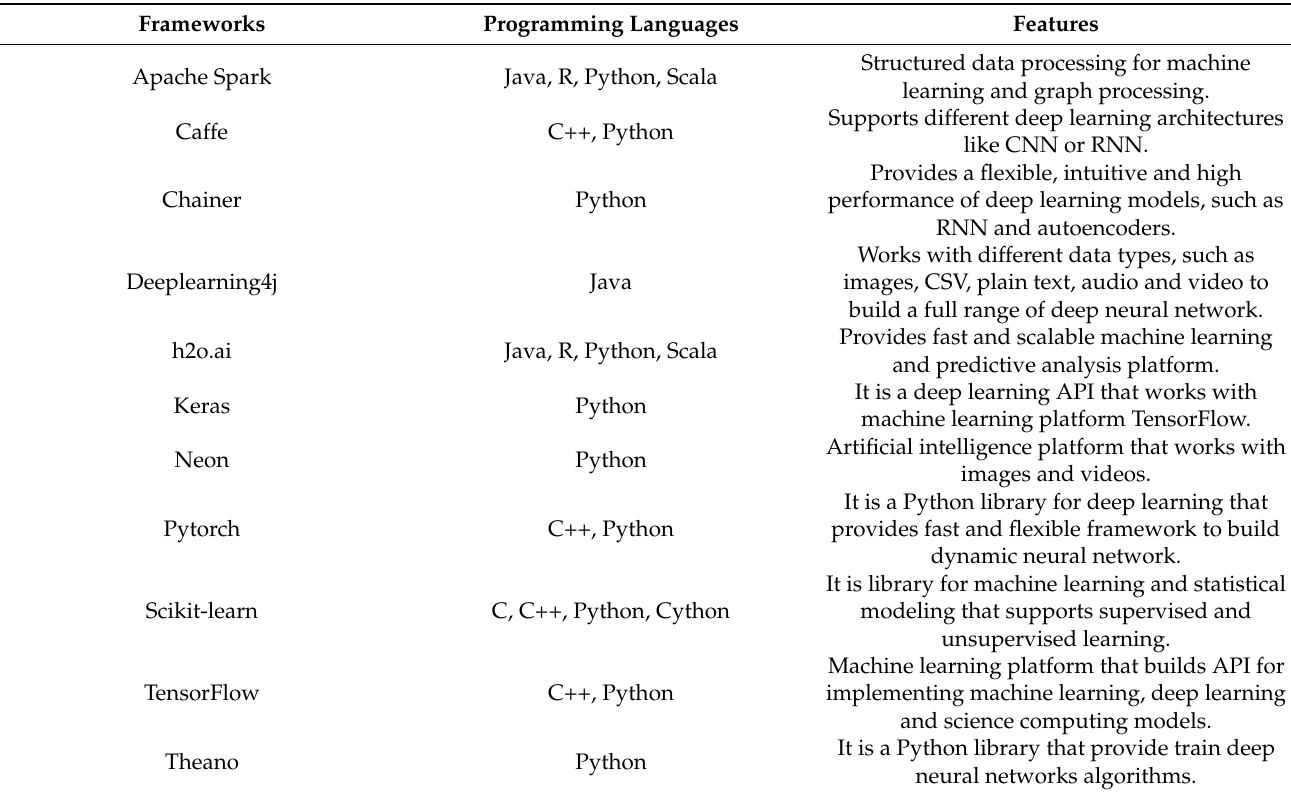
Table 1. Overview of the main open-source machine and deep learning frameworks.